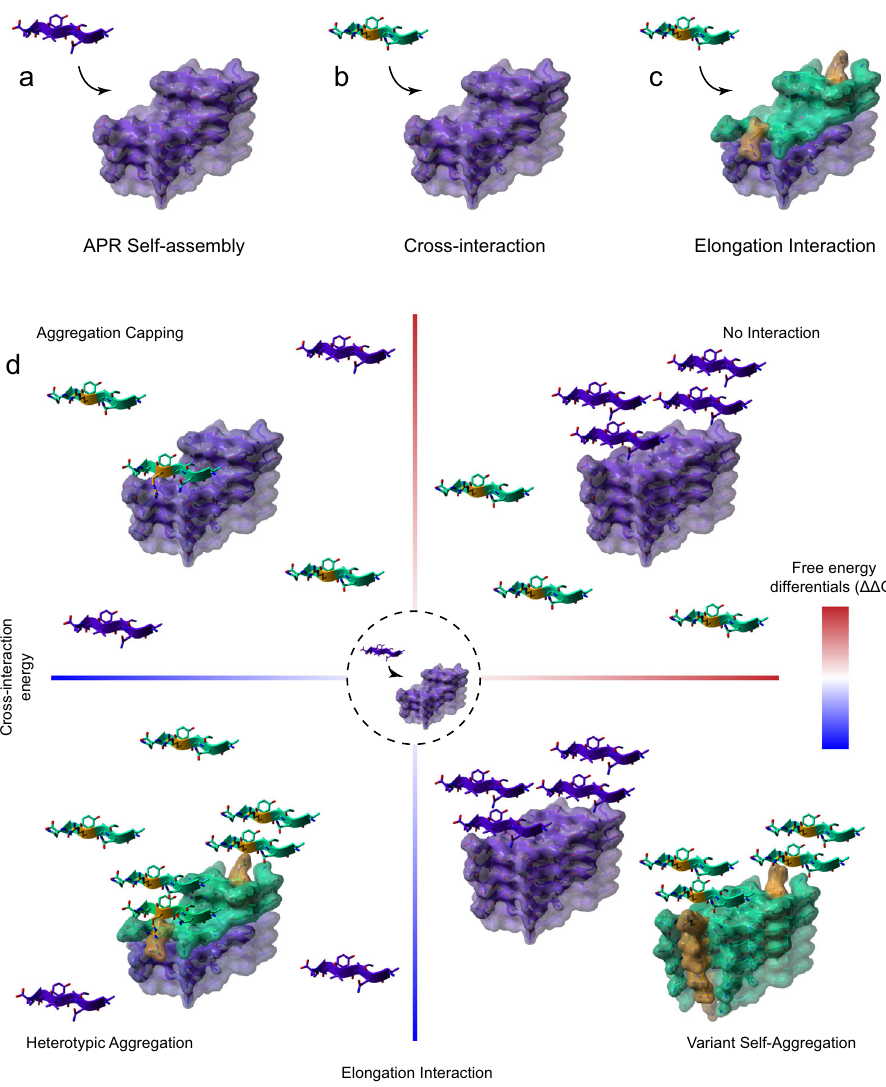
Fig. 1 Structural framework to describe cross-interactions of APR aggregation cores. a – c Three structural templates were generated for each APR amyloid core structure (shown in purple), corresponding to a self-elongation by monomeric APR addition (purple β -strands), b primary cross-interaction of a single position (highlighted in yellow) sequence variant (shown as green β -strands) at the amyloid fi bril ends and c successive elongation by the same variant. d Variants that produce favourable differentials compared to monomeric APR elongation are driven towards heterotypic aggregation, compared to disfavourable potentials that limit interactions. Aggregation capping is instigated by sequences that are compatible to cross-interactions with the APR core but block further elongation, while opposite energies are associated to individual self-aggregation,